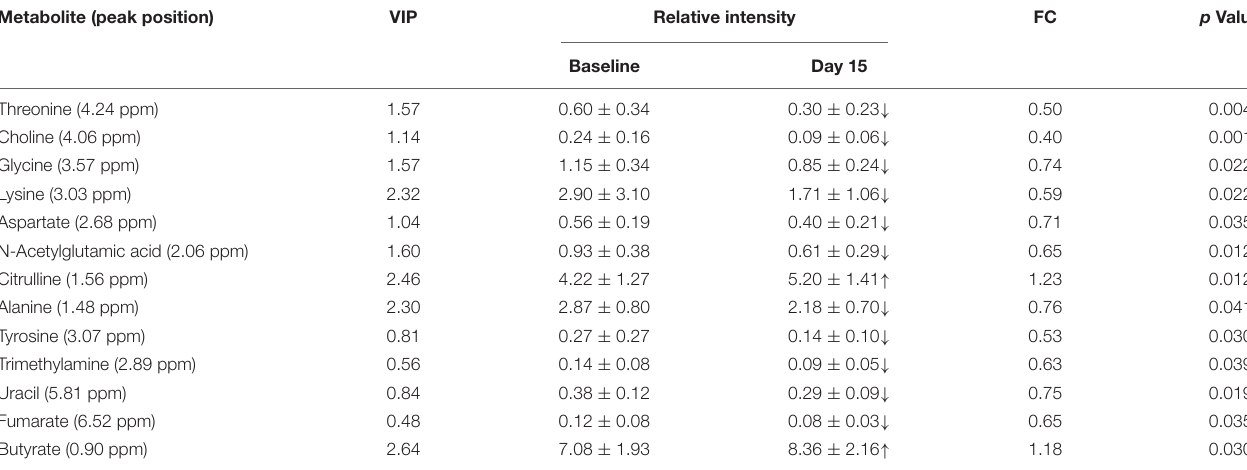
TABLE 2 | Statistical analysis results of the main metabolite in feces. Metabolite (peak position) VIP Relative intensity FC p Value Baseline